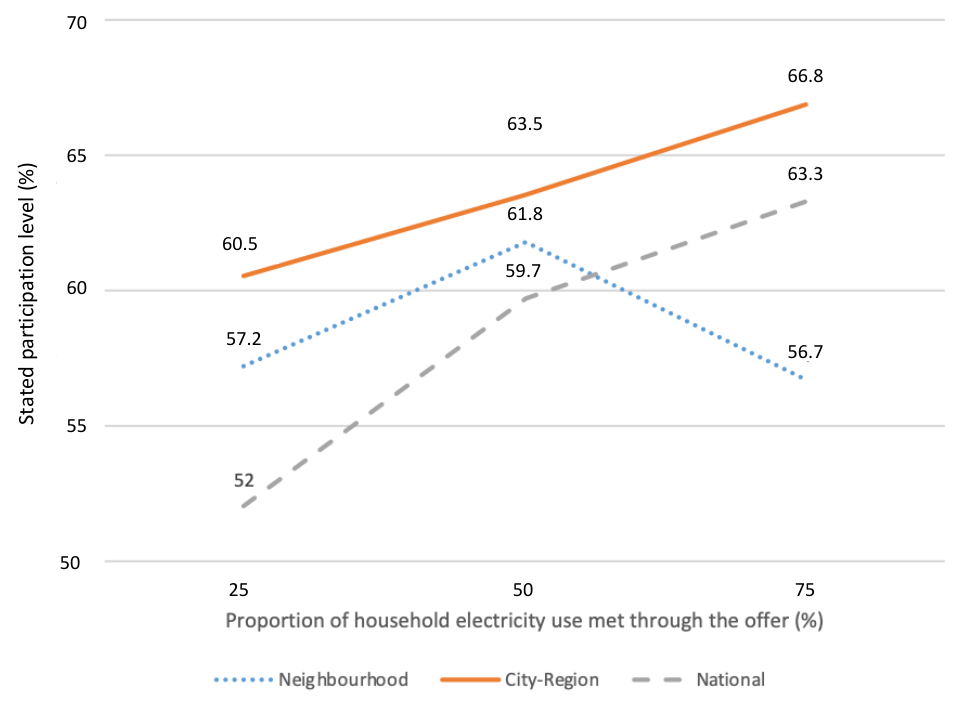
Figure 4. Stated participation level for di ff erent combinations of spatial scale and proportion of household consumption